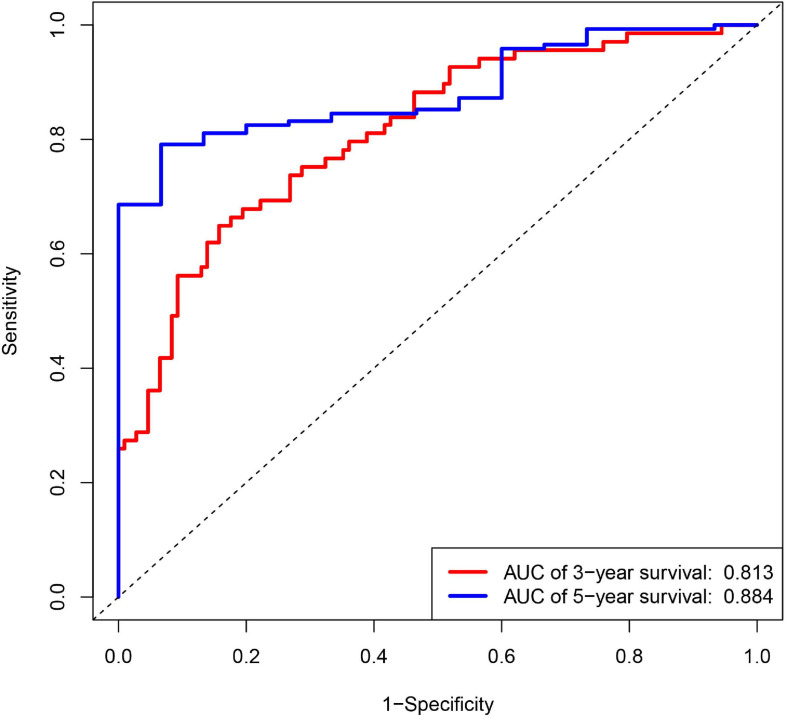
Receiver operating characteristic (ROC) curves for 3- and 5-year survival probability according to 14 IRGs signature in the training group.